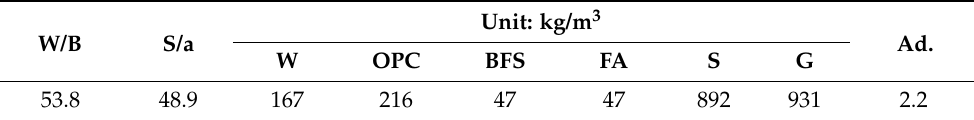
Table 3. Mixture proportion of concrete. Table 2. Mixture proportion of ECC.